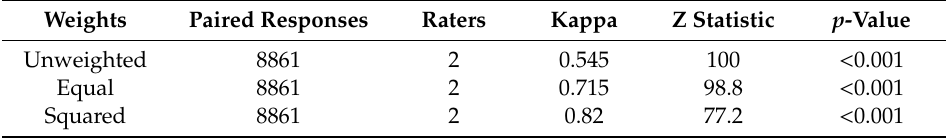
Table 6. Intra-rater reliability omnibus tests. Kappa scores representing the reliability of rater scores across a period of 30 days. Paired responses represent the number of paired responses from which the Kappa was calculated. They include questions × the number of horses (possible question pairs for comparison) minus “true” missing values.